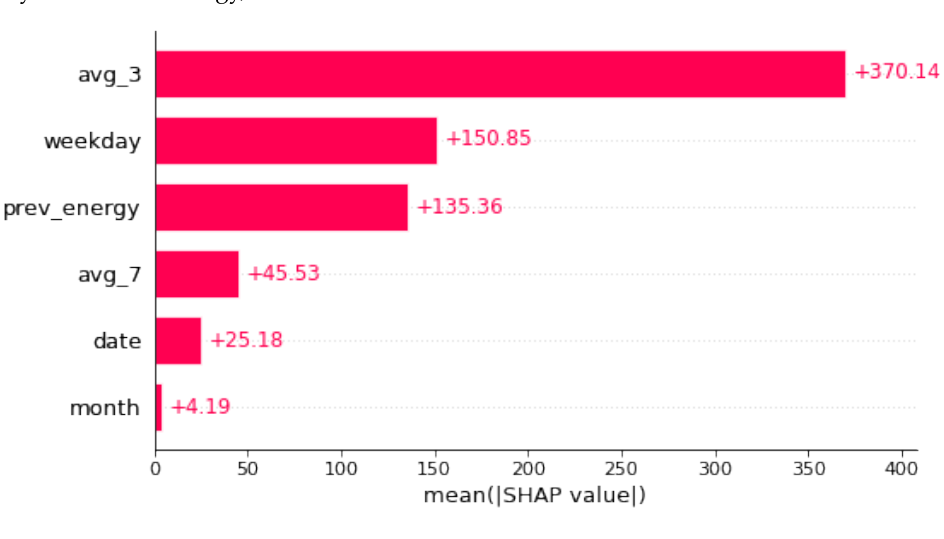
Figure 5. SHAP values of the best performing model.